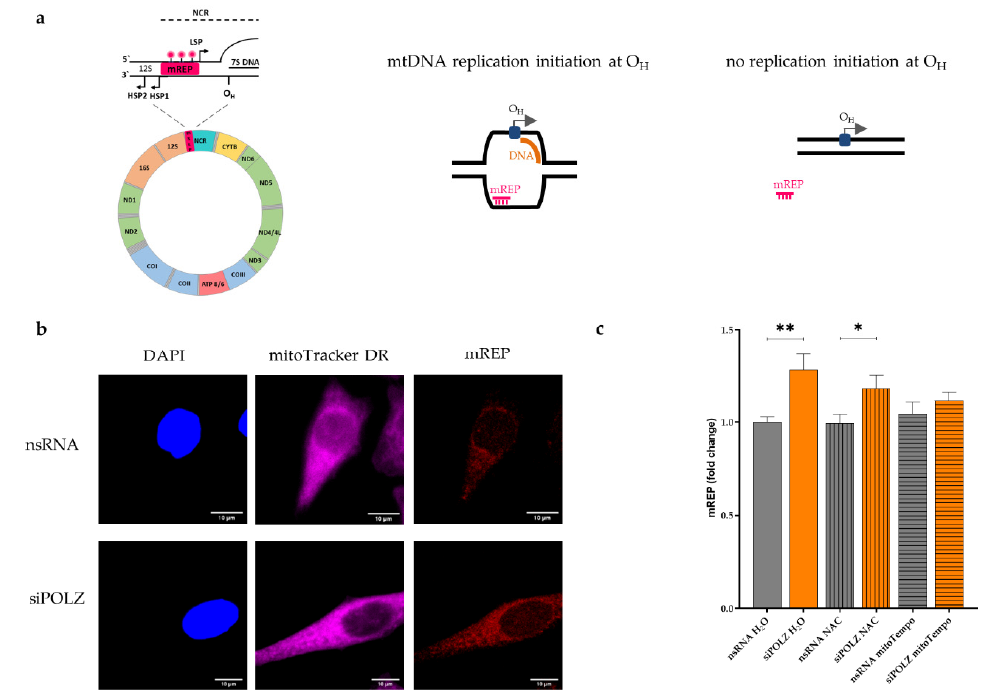
Figure 6. POLZ knockdown leads to compensatory mtDNA replication initiation under conditions of oxidative stress. Scheme of mREP recognition site in mitochondrial genome ( left , [29]) and mREP recognition of open DNA replication bubble when replication initiation occurs at O H ( right , [44]) ( a ). Representative confocal microscopic images of the mREP fluorescence signal of HeLa cells cultured in galactose media and siRNA-mediated knockdown for 48 h, scale bar = 10 µM ( b ). DAPI is used as a reference for the nuclear and extra-nuclear surface (mitochondria located over the nuclear surface may also be mREP-positive), and mitoTracker DR was used as a mitochondrial marker. Fluorescence- based quantification of mREP signal, n = 35–42 cells from 2 independent experiments, cultured in galactose medium, siRNA-mediated knockdown of POLZ for 48 h versus nsRNA control plus treatment with H 2 O, or 2 mM NAC or 100 µ M mitoTempo for 24 h ( c ). All values are means ± SEM (* p ≤ 0.05, ** p ≤